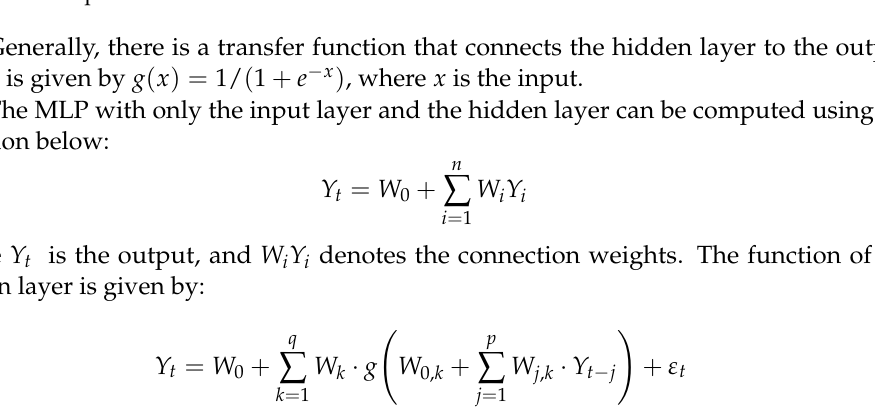
Figure 1. Example of a network structure of an ANN.